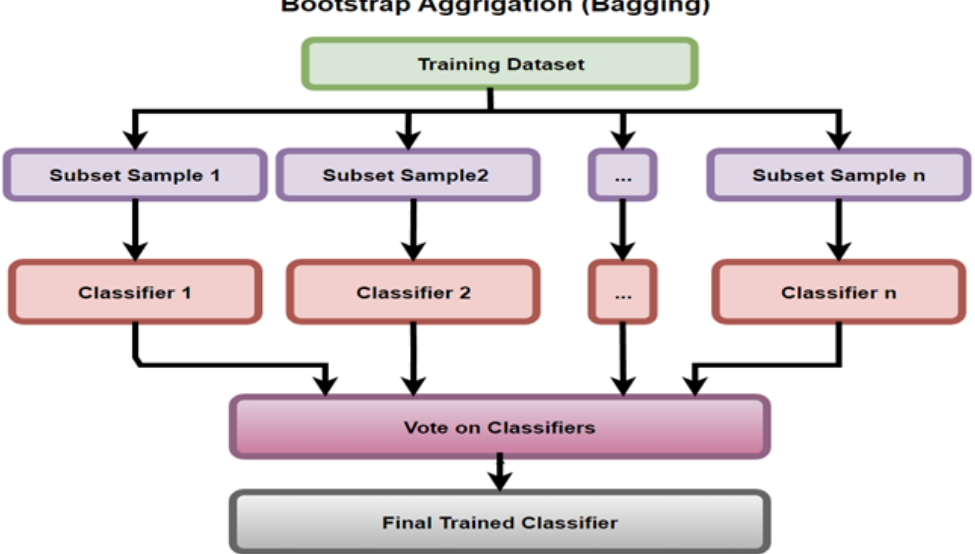
Figure 8. Bootstrap Aggregation A.K.A Bagging